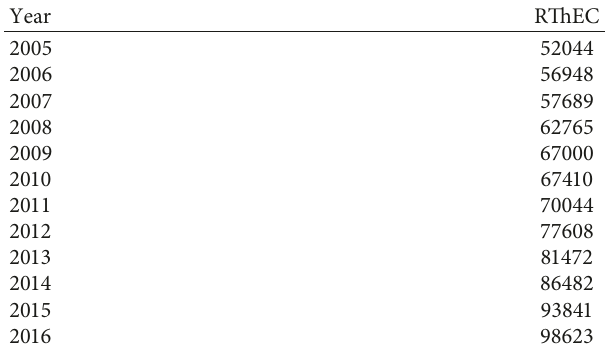
Figure 7: Comparison of the true value and the produced value by different grey models in Case 1. Table 13: Raw sequence of China’s residential thermal energy consumption (RThEC)